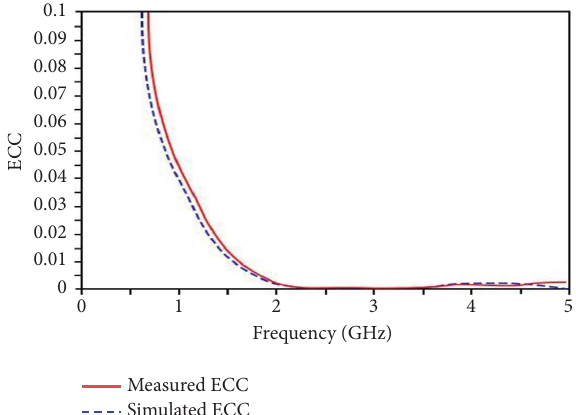
Figure 20: Simulated ECC response of 1 × 4 MIMO antenna.